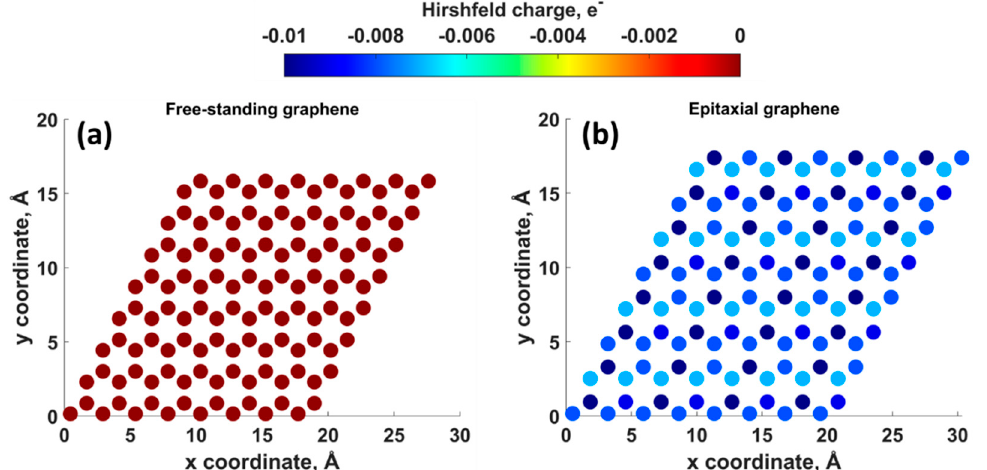
Figure 4. Charge redistribution maps (constructed based on Hirshfeld charges) of ( a ) free-standing graphene and ( b ) monolayer epitaxial graphene on 4H-SiC structure. The charge population analysis was performed within this work using 8 × 8 slabs (free-standing graphene and epitaxial graphene on SiC, respectively) at vdW/BH/DZP level of DFT by SIESTA code.